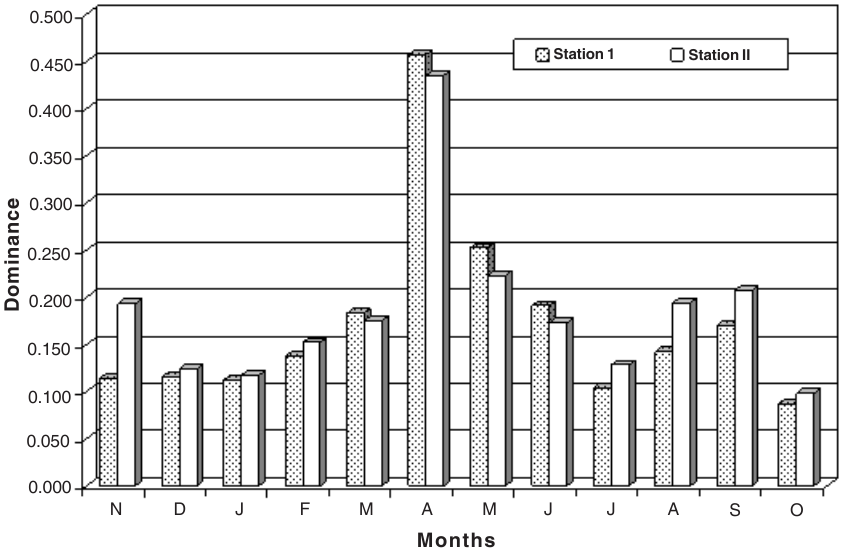
Figure 9. Monthly variations in dominance of